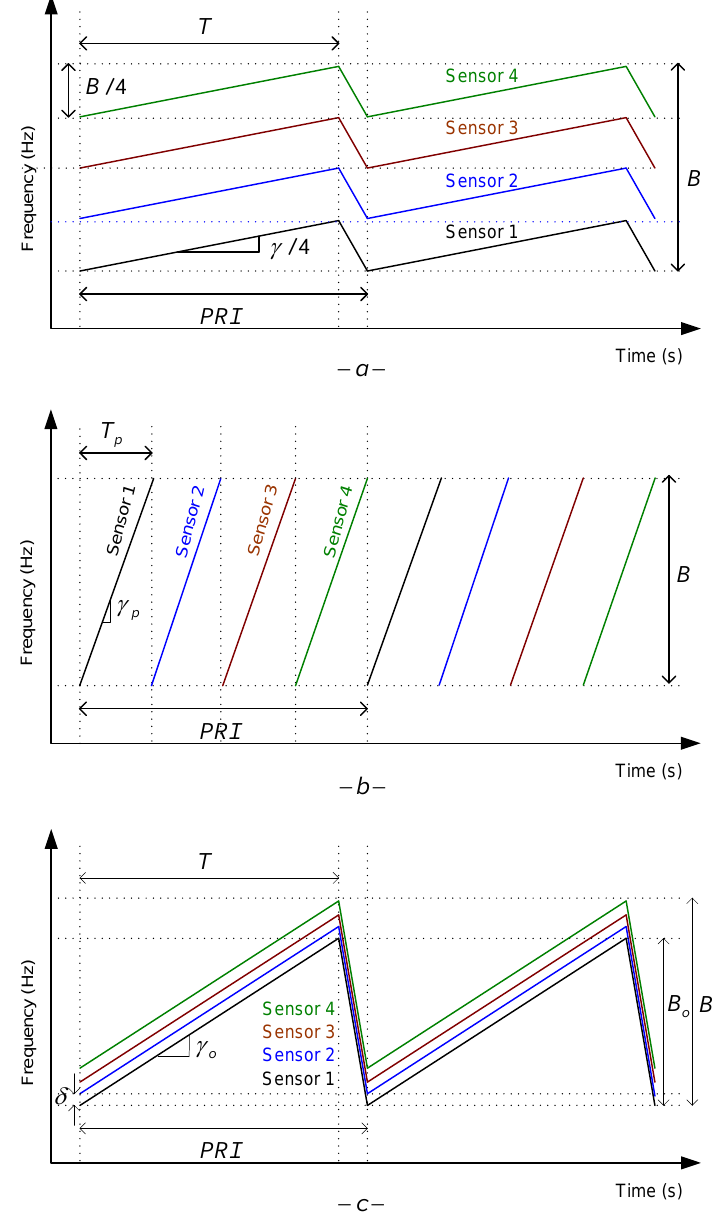
Figure 7. LFM waveforms: ( a ) FDMA LFM-CW ( b ) TDMA pulsed-LFM ( c ) Offset